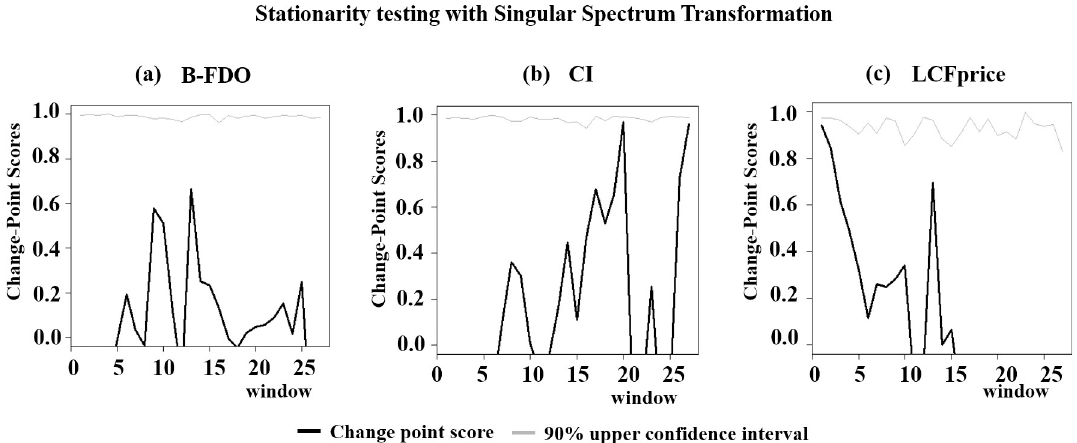
Fig 2. Testing for nonlinear stationarity with Singular Spectrum Transformation (SST). Change-point scores (black curves) resting below upper bootstrapped 90% confidence limits (grey curves) represent statistically insignificant abrupt shifts in dynamic structure violating nonlinear stationarity. SST did not detect significant change points in the B-FDO signal (indicating that the NORS data was compatible with the cycles driving the FDOSS data), the CI signal, or the LCFprice signal with the Trend 2 component removed (Fig 1 (C), right panel, green